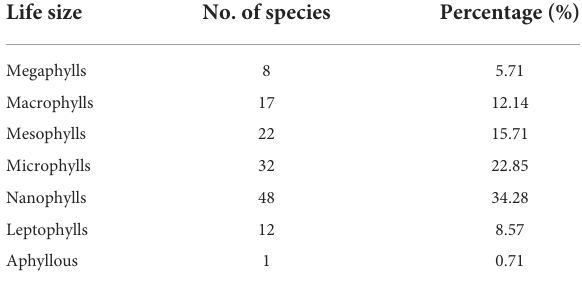
TABLE 3 Life form spectra of the Bin Dara, Dir,